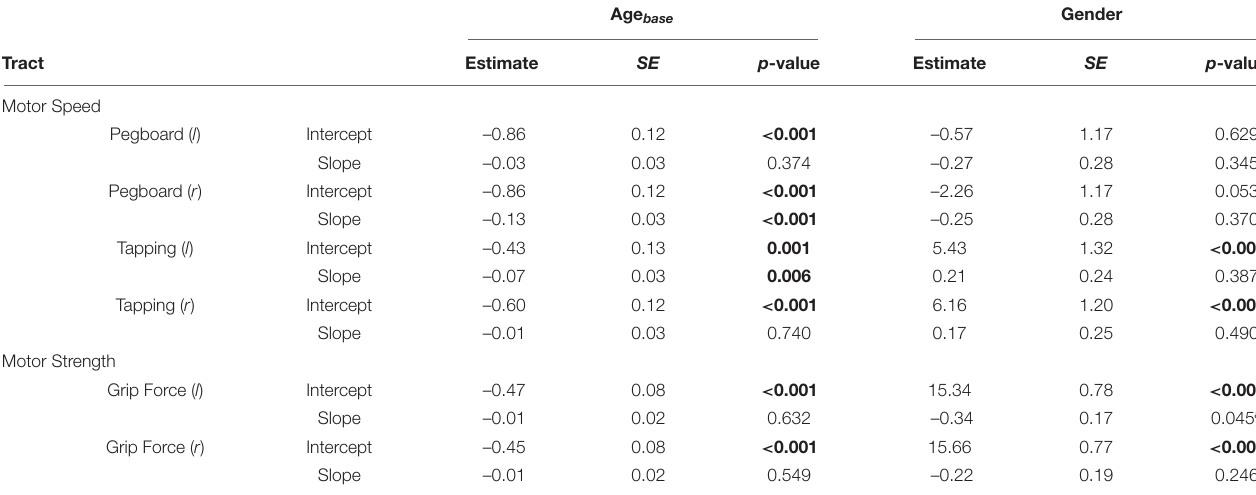
TABLE 7 | Effects of Age at baseline and Gender on intercept and slope of best fitting univariate LGC models for motor